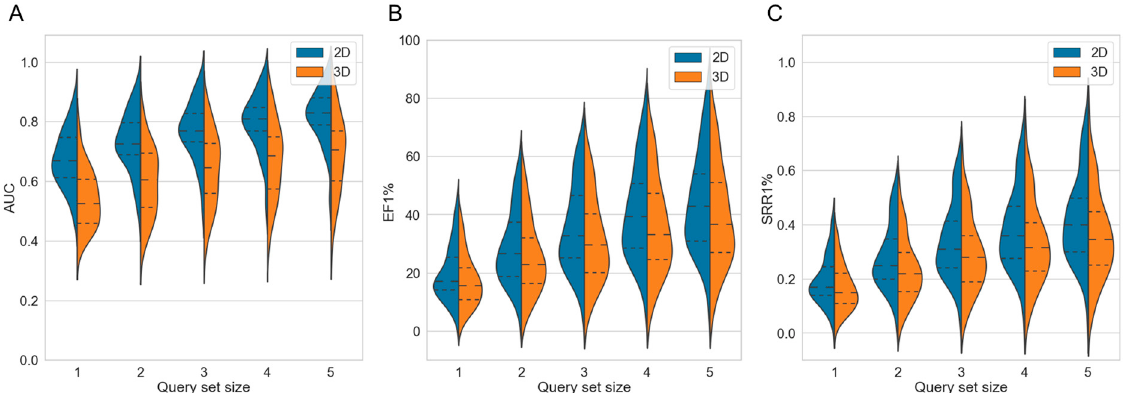
Figure 3. Violin plots showing the distributions of ( A ) AUC, ( B ) EF1% and ( C ) SRR1% values obtained by the 2D fingerprint-based method and the 3D shape-based method over the 50 investigated targets, with different sizes of the query sets. The dashed lines mark the quartiles of the distribution.